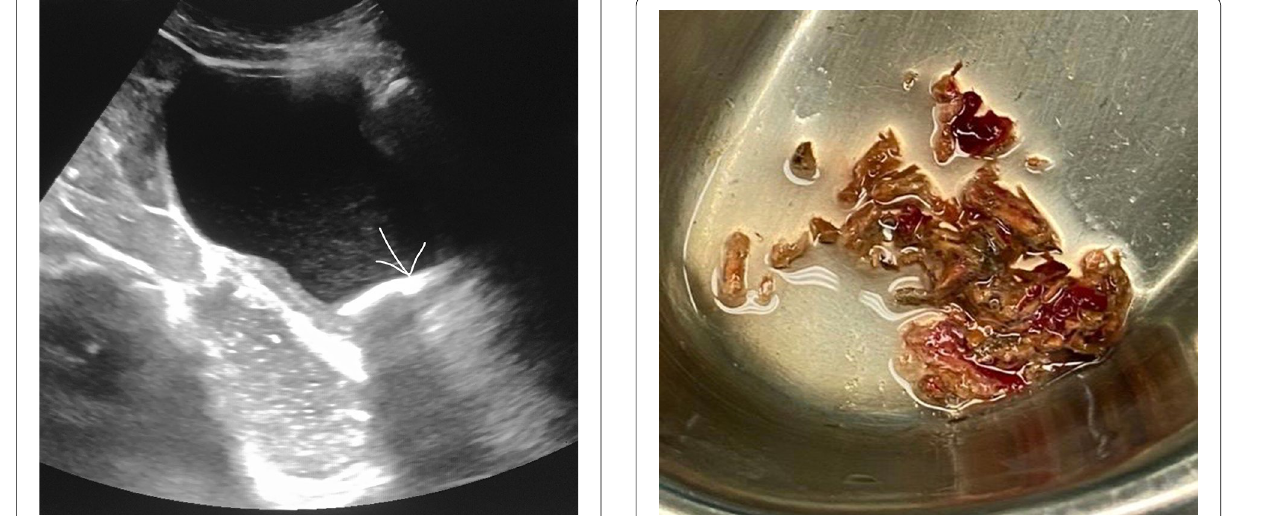
Fig. 2 Ultrasound showing intravesical foreign body Fig. 3 Part of the fragments retrieved using Ellick bladder